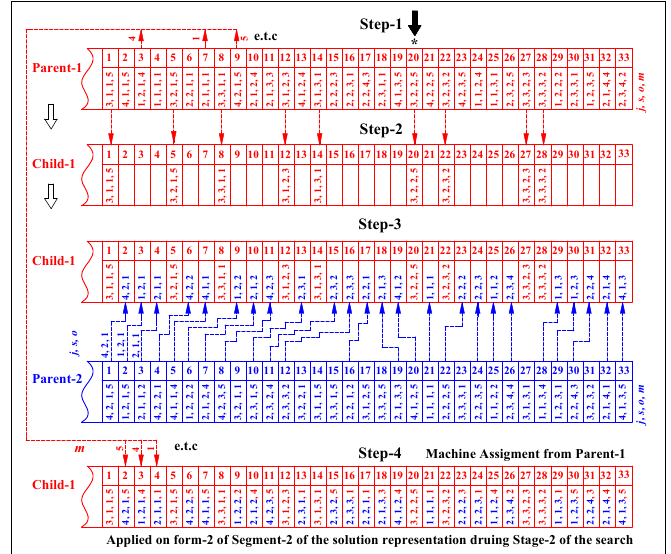
Applied on form-2 of Segment-2 of the solution representation druing Stage-2 of the search Figure 7. Illustration of the JLOSC crossover operator (an asterisk * in Step-1 denotes the location of an arbitrarily selected gene).